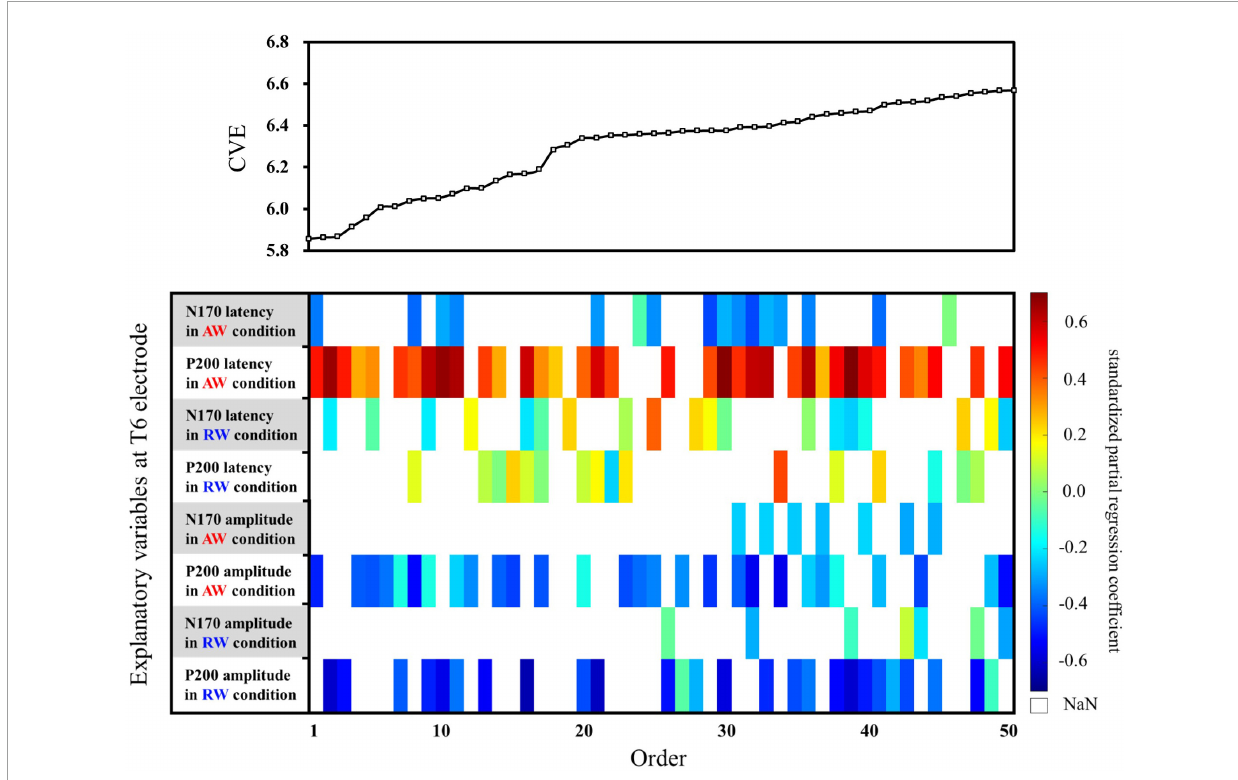
FIGURE5 Graph showing the values of the cross-validation errors (upper panel) and weight diagram plots (lower panel) for each model when performing multiple regression analysis with ES. The SATQ scores of each participant were the objective variables and eight ERP indicators at electrodes T6 [(latencies and amplitudes) × (N170 and P200) × (in AW and RW conditions)] were the explanatory variables. Fifty of the 255 different models are arranged along the horizontal axis based on the model with the smallest CVE. The vertical axis presents the eight explanatory variables. At the T6 electrode, “P200 latency in AW condition” (second row from the top) was the most frequently selected explanatory variable in 36 of the 50 models. The second most frequently selected variable was “P200 amplitude in the AW condition” (third row from the bottom), which was selected 28 times from among the 50 models. AW, approaching walking movement; RW, receding walking movement; ST, standing; SATQ, subthreshold autism trait questionnaire; ERP, event-related potential; ES, exhaustive search.